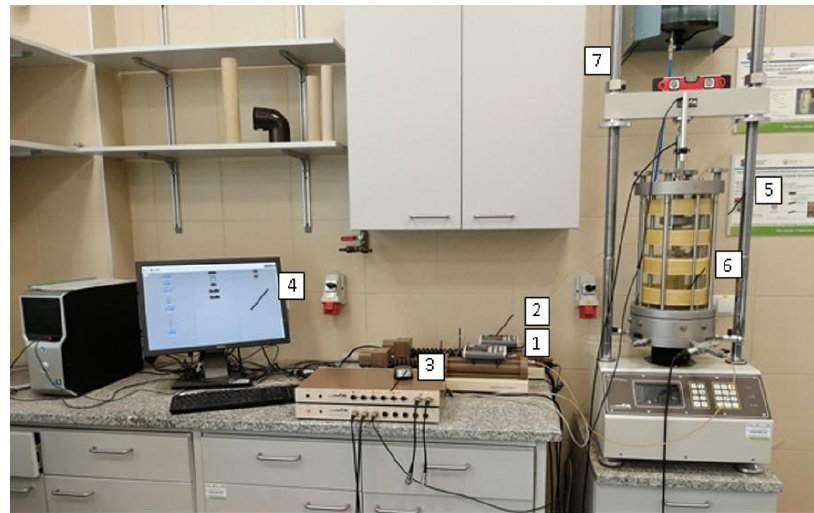
Figure 3. Set-up of dynamic testing system at Water Centre in Warsaw University of Life Sciences: (1) back pressure controller, (2) cell pressure controller, (3) data logger, (4) PC and control software, (5) frame, (6) cell, (7) water tank.